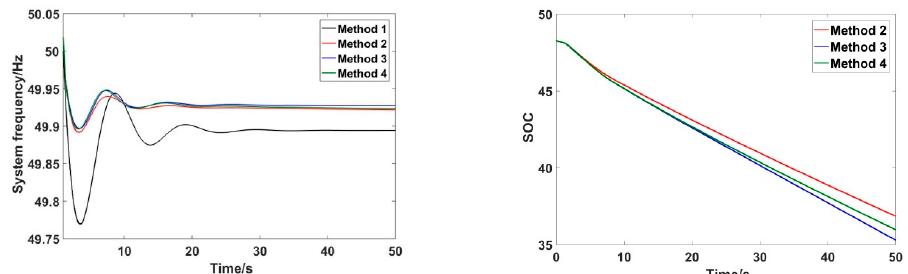
Figure 16. Results of 22 MW step load disturbance.